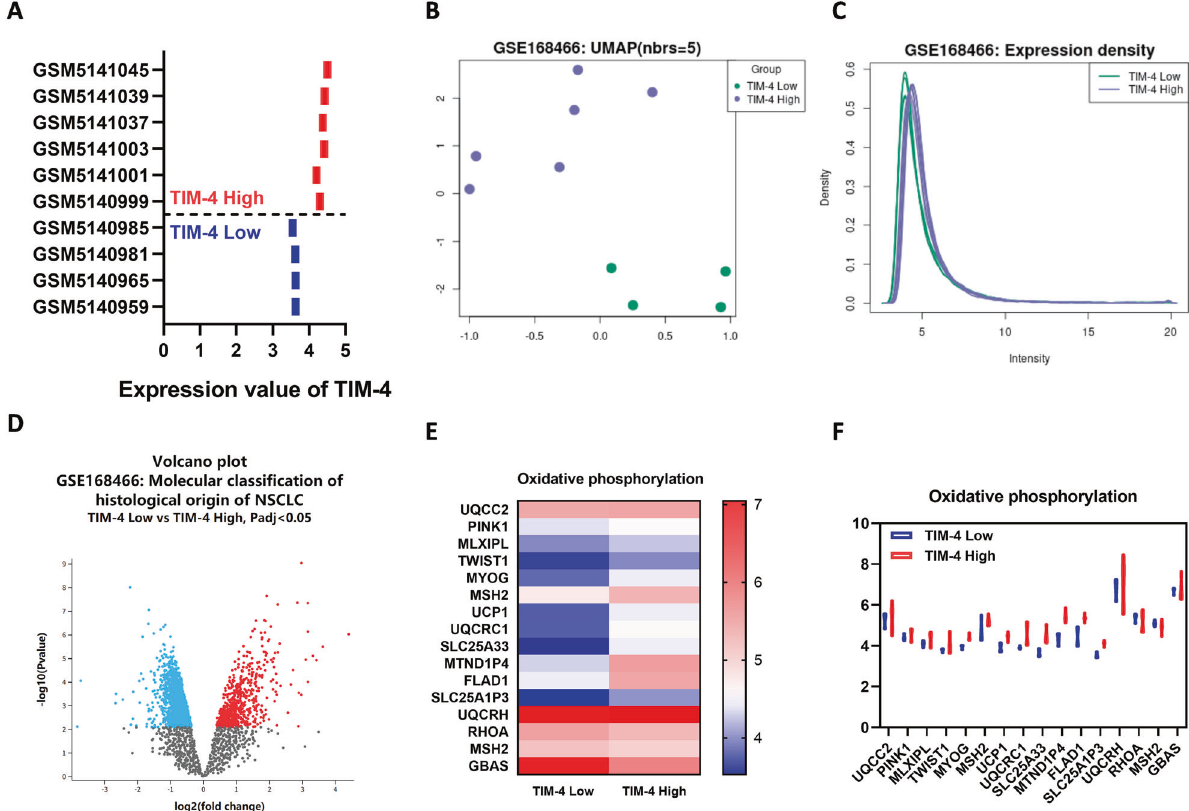
Fig. 6 OXPHOS-related genes are upregulated in TIM-4 High patients. A Expression value of TIM-4 in tumor samples of 10 patients with NSCLC (TIM-4 High , n = 6; TIM-4 Low , n = 4) (Gene Expression Omnibus accession no. GSE168466). B Uniform Manifold Approximation and Projection (UMAP) showed signi fi cant differences between the two groups. C Normalization of the data analyzed by GEO2R. D Volcano plot of differentially expressed genes in tumor samples of 10 patients with NSCLC. E Heatmap of oxidative phosphorylation related genes expression in two groups. F Expression values of OXPHOS-related genes in TIM-4 High and TIM-4 Low